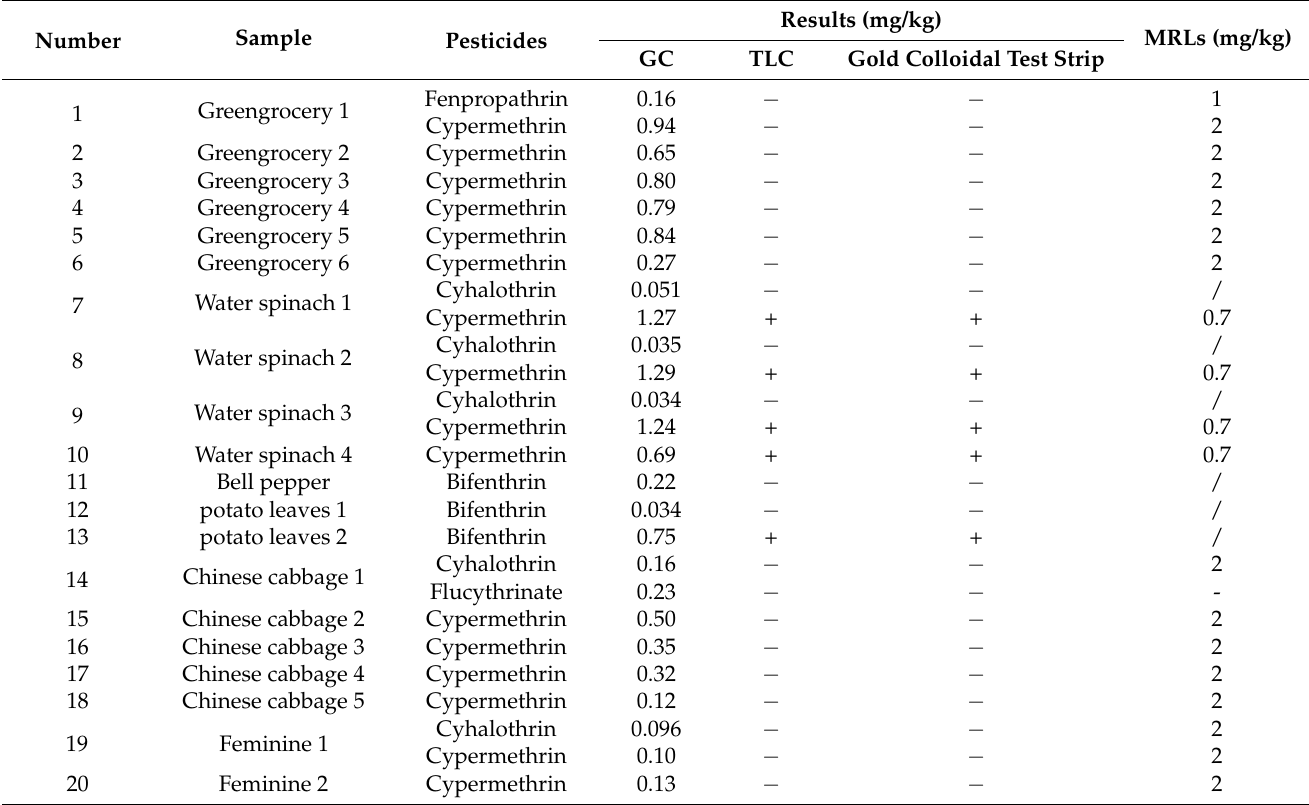
Table 5. The detection results of 20 pyrethroid-containing practical vegetable samples.